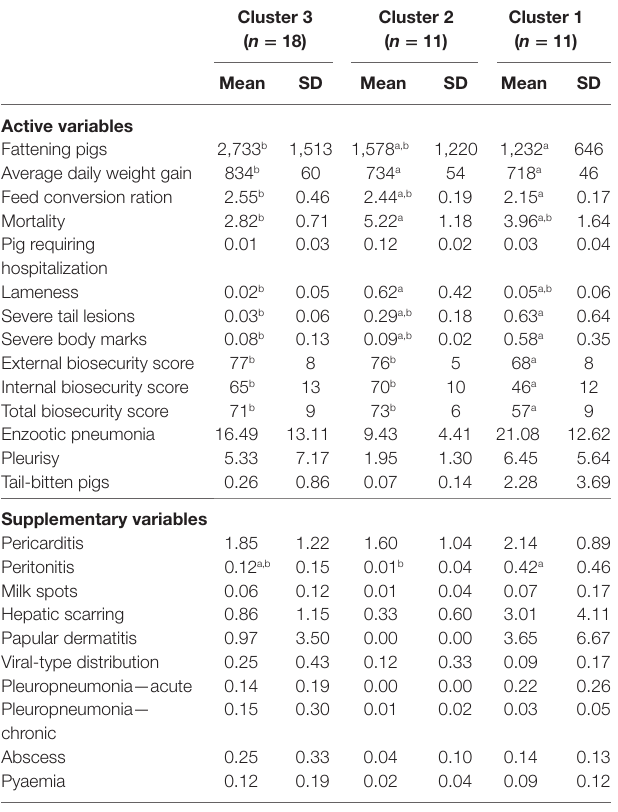
TaBle 9 | Mean and SD of biosecurity scores, health indicators, welfare outcomes, and production performance, and of the study sample of fattening pig farms in Great Britain according to three clusters derived from the PCA analysis (based on the active